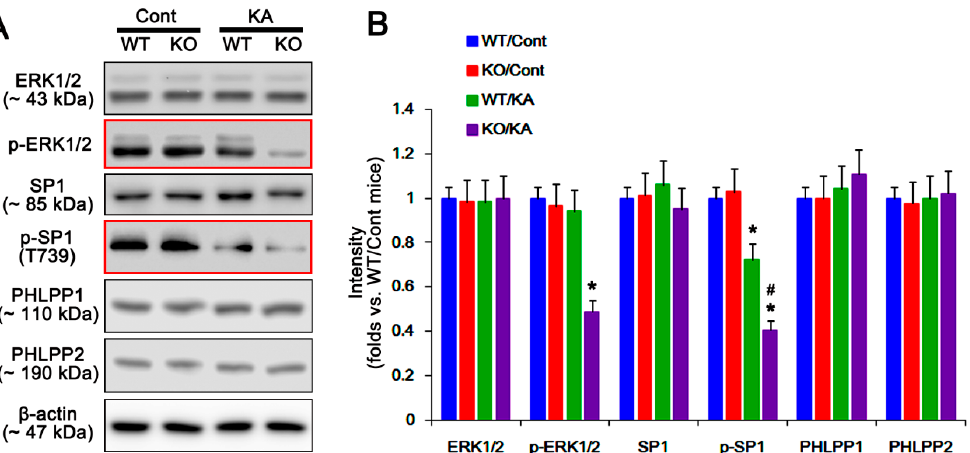
Figure 7. Effects of P2X7R deletion on expressions and phosphorylations of extracellular regulated kinase 1/2 (ERK1/2), specificity protein 1 ( SP1), pleckstrin homology domain, and leucine-rich repeat protein phosphatase 1 (PHLPP1) and PHLPP2 in isolated astrocytes following KA injection. As compared to WT astrocytes, KA reduces p-ERK1/2 and p-SP1 levels in KO astrocytes 7 days after KA injection (red box). ( A ) Representative Western blot of expressions and phosphorylations of ERK1/2, SP1, PHLPP1, and PHLPP2 in isolated astrocytes following KA injection. Cont, control animals; KA, KA-injected animals. ( B ) Quantifications of expressions and phosphorylations of ERK1/2, SP1, PHLPP1, and PHLPP2 in isolated astrocytes following KA injection (mean ± SEM; * ,# p < 0.05 vs. Control WT astrocytes and KA-treated WT astrocytes, respectively; n = 7, respectively).